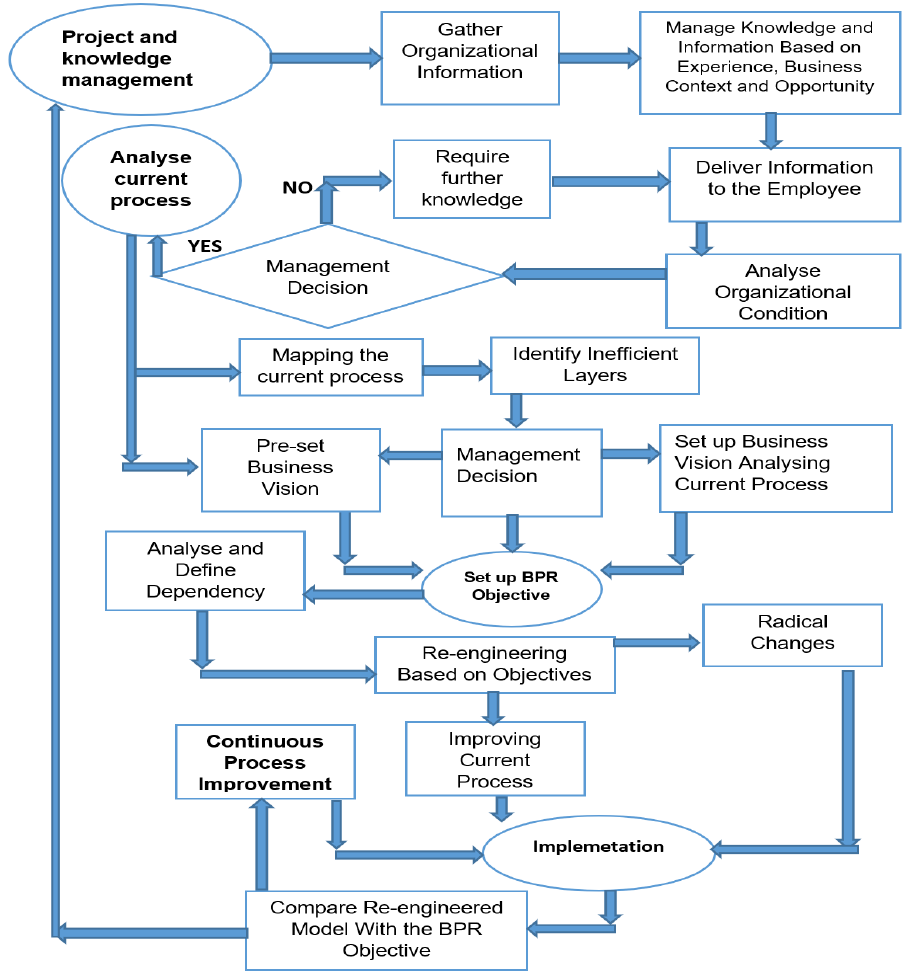
Figure 9. Methodology and implementation technique.